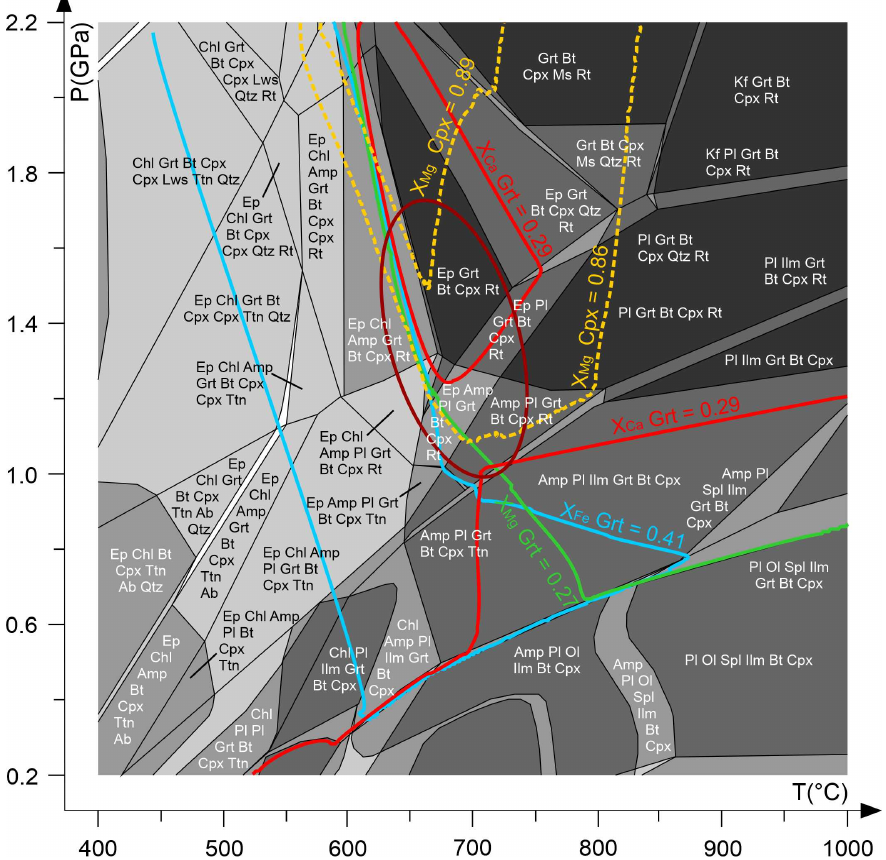
Figure 8. P–T pseudosection calculated in the NCKFMASH + Ti + Mn system for the bulk rock composition of the host rock (ultrabasic amphibolite, Layer C), and estimated P–T conditions for the growth of garnet in host rock (purple ellipse). Blue, green, and red lines show the almandine (X Fe = Fe/Fe + Mg + Mn + Ca), pyrope (X Mg = Mg/Fe + Mg + Mn + Ca), and grossular (X Ca = Ca/Fe + Mg + Mn + Ca) components in garnet. Yellow dashed lines show the X Mg ratio (Mg/Mg + Fe) in clinopyroxene.